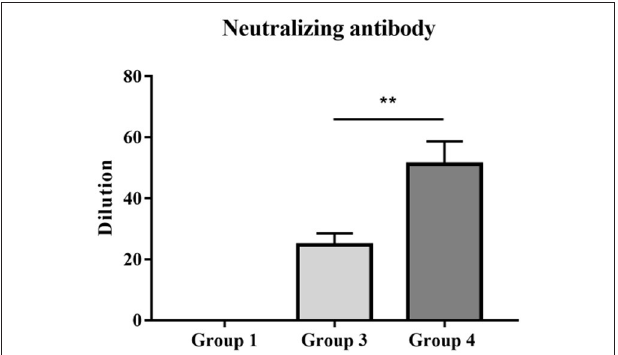
FIGURE 5 | PRRSV titers of vaccinated piglets with anti-sera. The neutralizing activities of serum samples collected 21 dpv were detected against homologous JXA1 strain. Statistical significance is denoted by ** p <